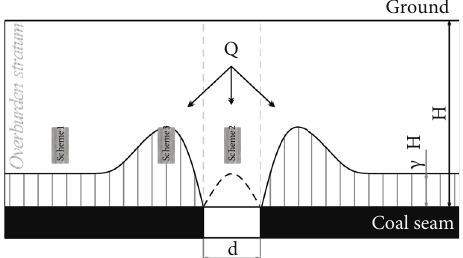
Figure 2: The stress environment of gob surrounding rock ( d : the width of open-o ff cut; γ : unit weight of rock; H : thickness of rock; Q : weight of gob overburden